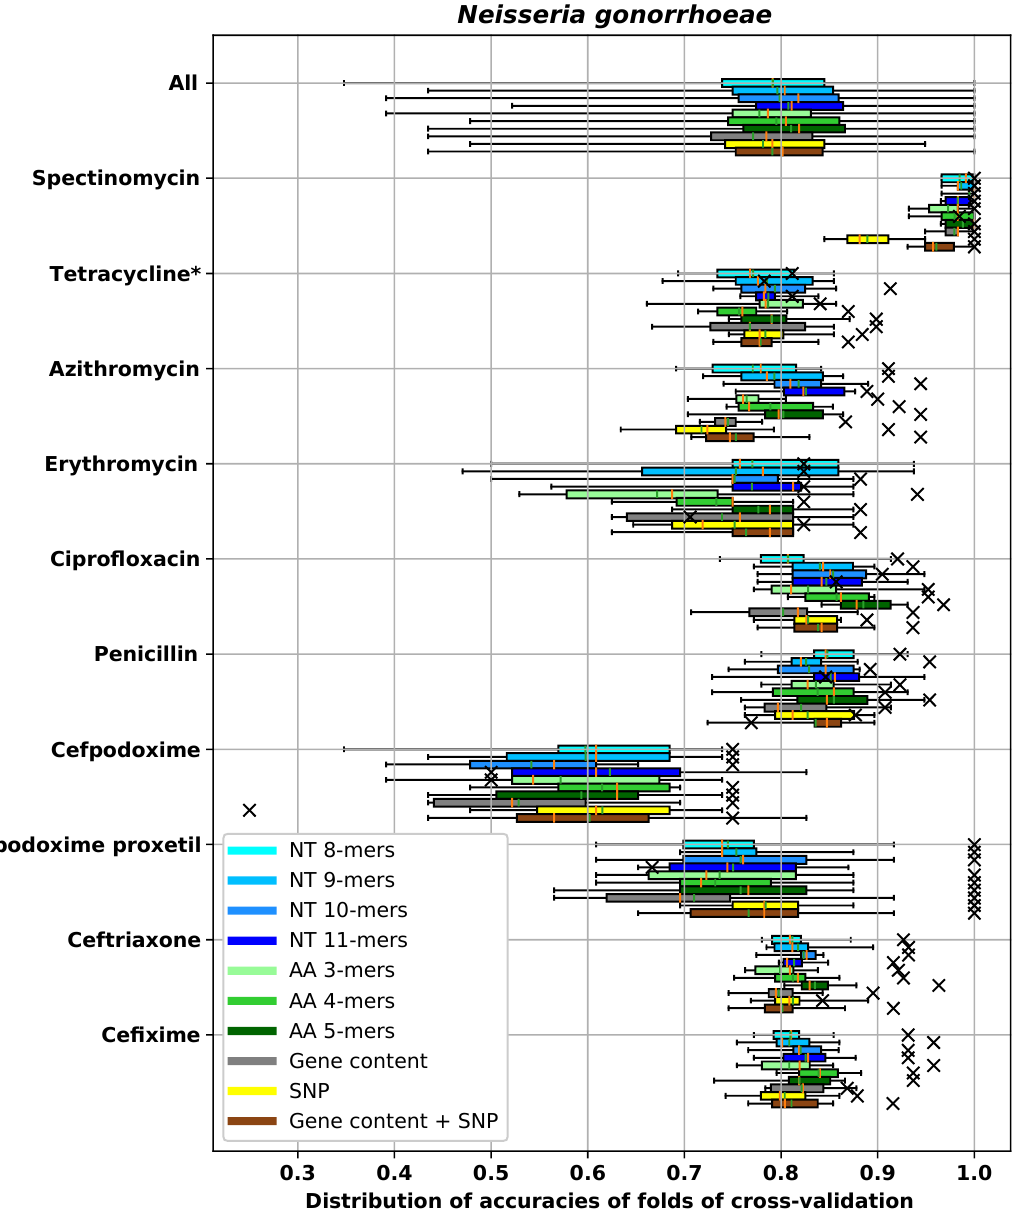
Figure 6. Distribution of ± 1 two-fold dilution accuracies in different methods for Neisseria gonorrhoeae . Plots are similar to Figure